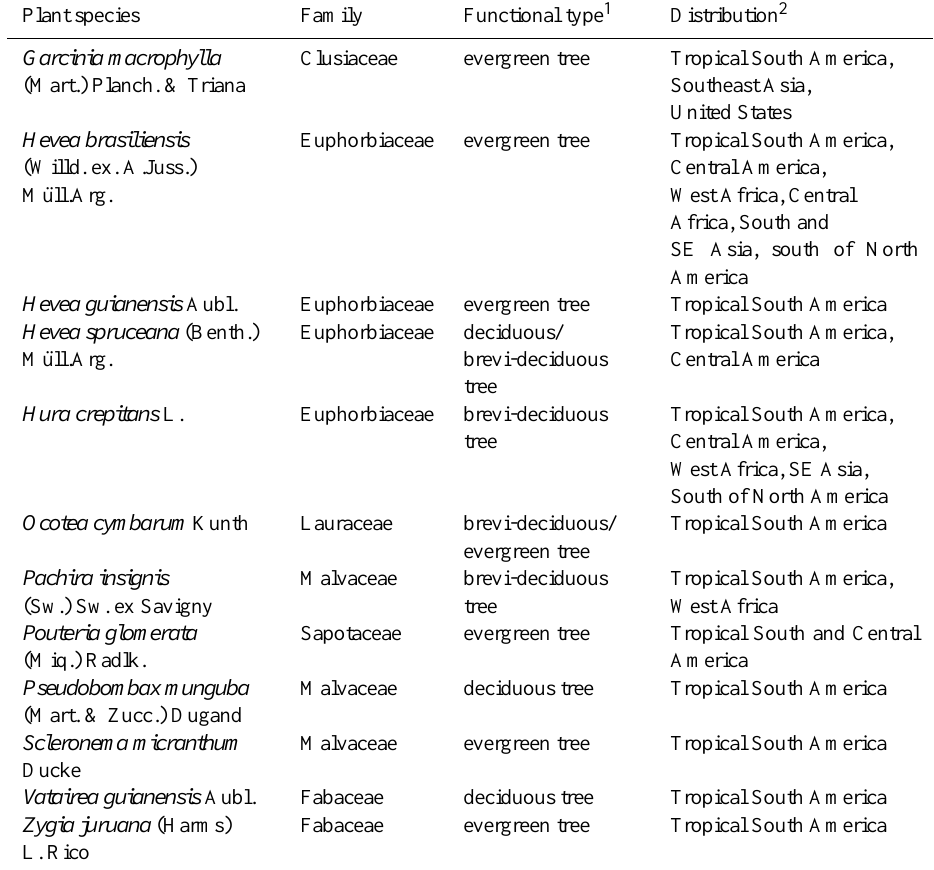
Table 1. Plant species, family, functional type, ecosystem and distribution of the 12 investigated tropical plant species. Plant